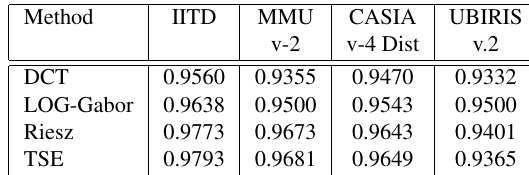
Table 1. RI obtained by the experiments conducted using different filters with respect to the four databases. Distance measure is the Hamming distance in all the cases.